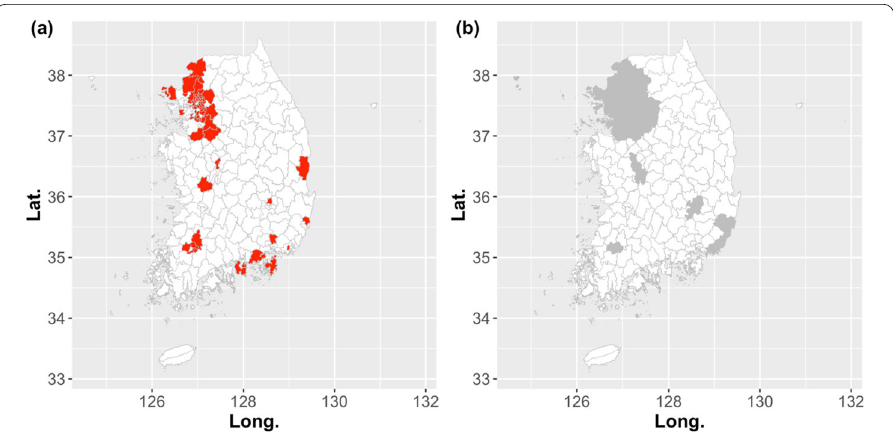
Figure 11 The regions that peak earlier than other regions. The city-county-districts where the influenza peak week is earlier than or equals to M p for all seven influenza seasons are marked as red in Fig. 11( a ). Here, M p is the median of influenza peak weeks. In Fig. 11( b ), we show the metro and rural areas depicted in gray and white, respectively, for comparison